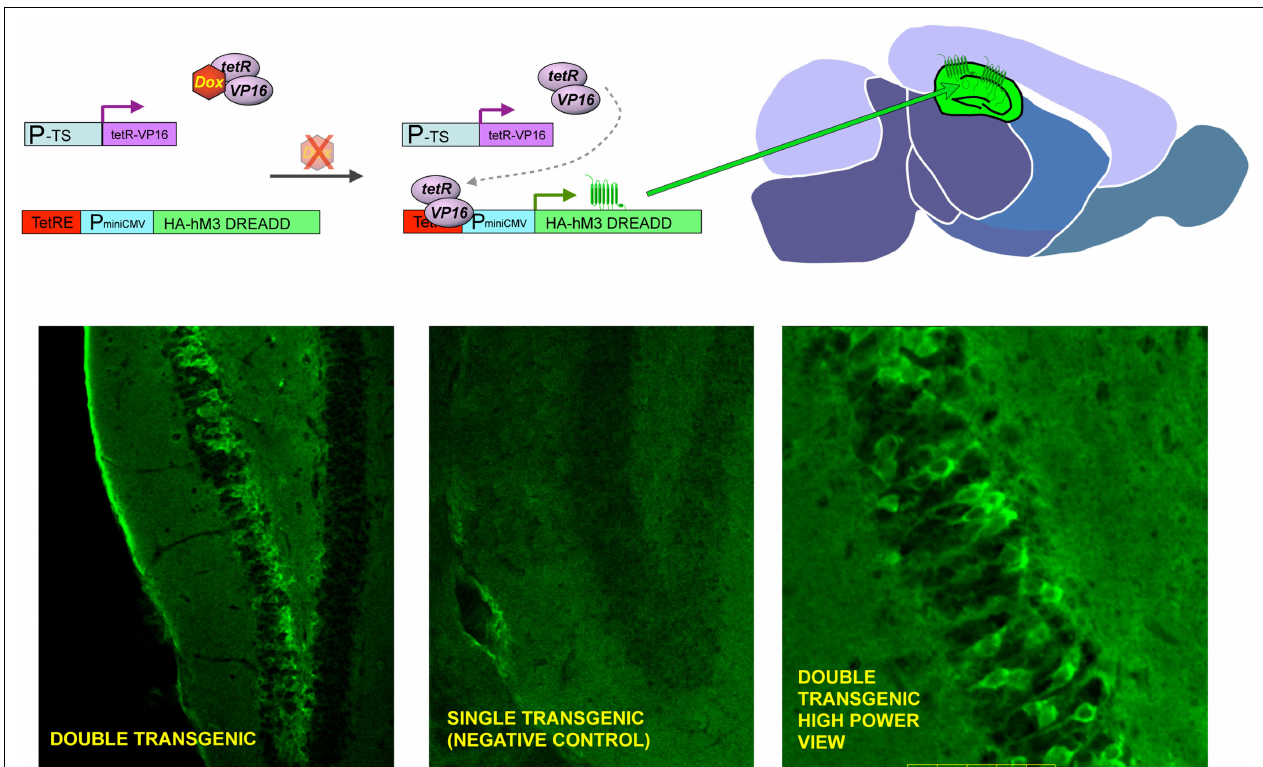
FIGURE 2 | General strategy to achieve inducible, tissue-specifi c expression of DREADDs. The upper panel shows the basic strategy to generate tissue specifi c expression of DREADDs in mouse brain. Double transgenic animals are made where one element contains a tissue specifi c promotor (P-TS) driving expression of the tetR-VP16 fusion protein, and the other contains the tetracycline response element (TetRE), followed by a minimal CMV promoter driving expression of HA-tagged DREADDs. Whereas both transgenic elements are present in every cell throughout the body, expression of tetR-VP19 is only in